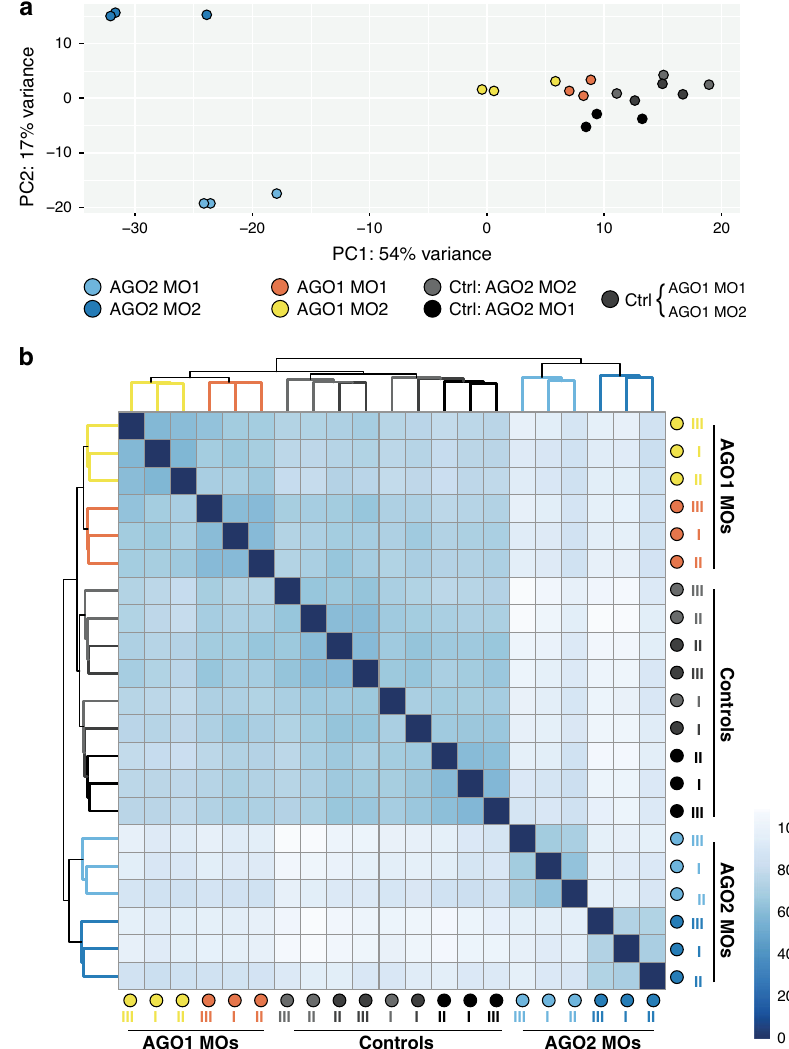
Fig. 2 NveAGO1 and NveAGO2 knockdowns exhibit distinct transcriptomic signatures. a Principal component analysis (PCA) plot and dendrogram ( b ) exhibiting differences in transcriptomic signatures for three distinct biological replicates of NveAGO1 and NveAGO2 knockdowns (two different MOs for each NveAGO). NveAGO1 MO1 and NveAGO1 MO2 were injected in parallel to the same control MO. STAR 66 was used to align reads to Nematostella